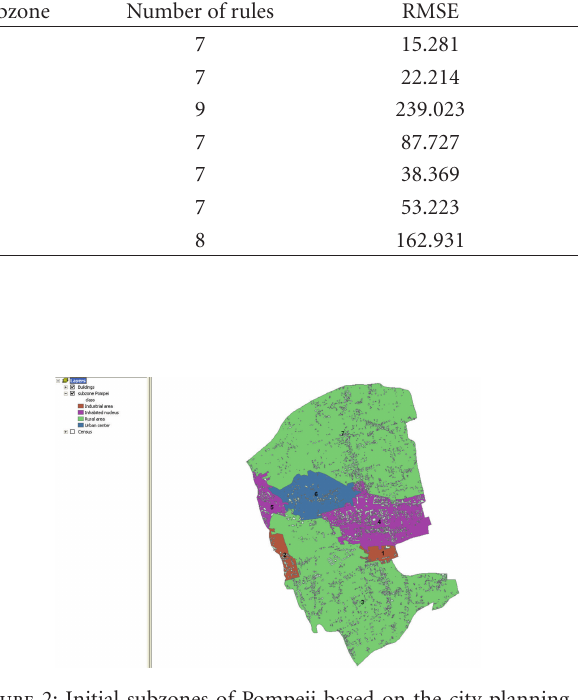
Figure 2: Initial subzones of Pompeii based on the city planning class.